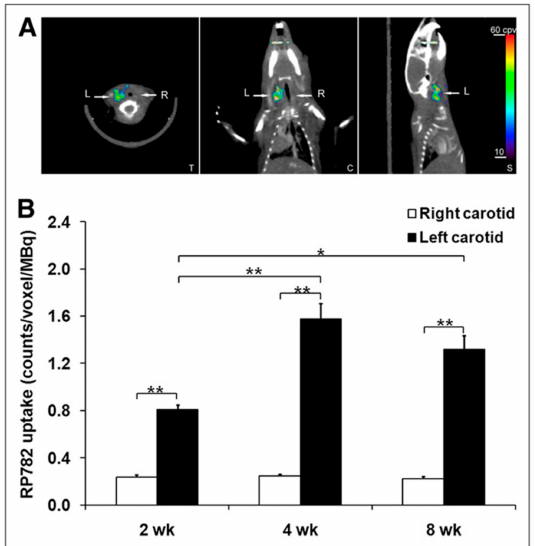
Figure 5. In vivo imaging of MMP activation in aneurysm. ( A ) An example of fused micro SPECT / CT imagesofmouseat4weeksaftersurgerytoinducecarotidaneurysm. Thearrowspointtoaneurysmalleft(L) and control right (R) carotid arteries. ( B ) The image-derived quantitative analysis of background-corrected [ 111 In] 56 (RP782) carotid uptake. The background-corrected tracer uptake in left carotid artery peaked at 4 weeks after surgery and was significantly higher than uptake in right carotid artery at every time point studied. n 5 16-18 in each group. * p = 0.01. ** p < 0.001. C 5 coronal slice; S 5 sagittal slice; T 5 transverse slice. Reprinted with permission from [98] copyright © 2010 by the Society of Nuclear Medicine,